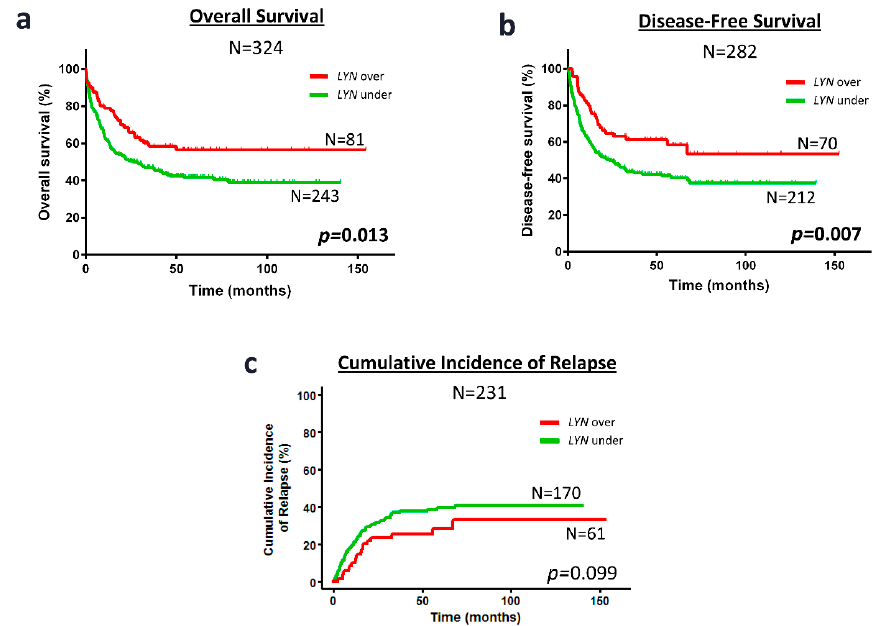
Figure 3. LYN overexpression associates with favorable prognosis regarding OS and DFS in cytogenetic IR-AML patients. Kaplan-Meier curves represent OS ( a ) DFS ( b ) and CIR ( c ), depending on the LYN expression. Black line and gray line indicate LYN overexpressed and underexpressed, respectively. Log-rank test for OS and DFS, and Gray test for CIR were used to analyze the statistical significance. p < 0.05 was considered statistically significant (bold values).